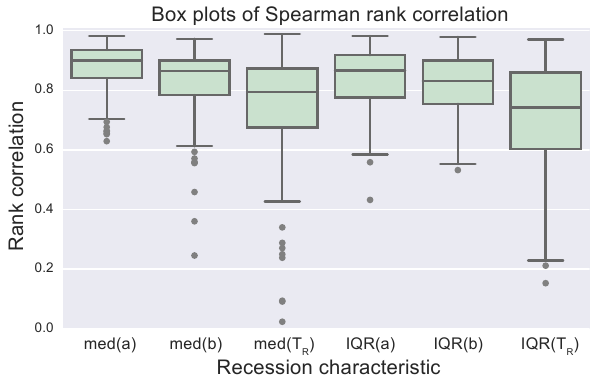
Figure 7. Box and whisker plots of Spearman rank correlations for all six descriptive measures of the distributions of a , b , and T R . Per characteristic, there are 15 × 16 = 240 unique pairwise comparisons between method